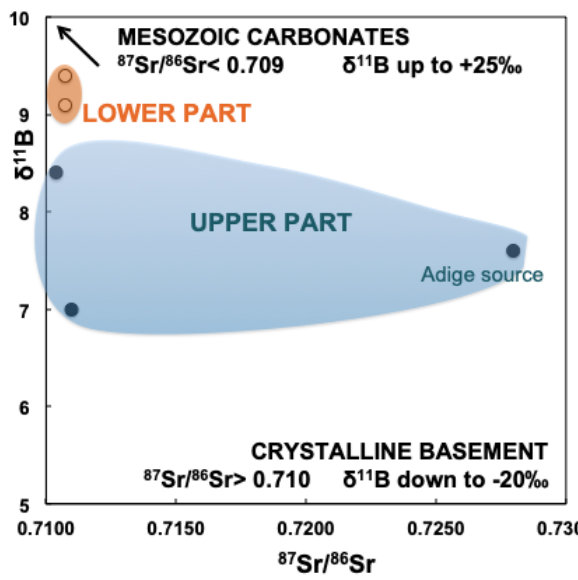
Figure 7. 87 Sr / 86 Sr and δ 11 B in Adige river water compared with the isotopic fingerprint of crystalline rocks of the basement and Mesozoic carbonates [65–68].